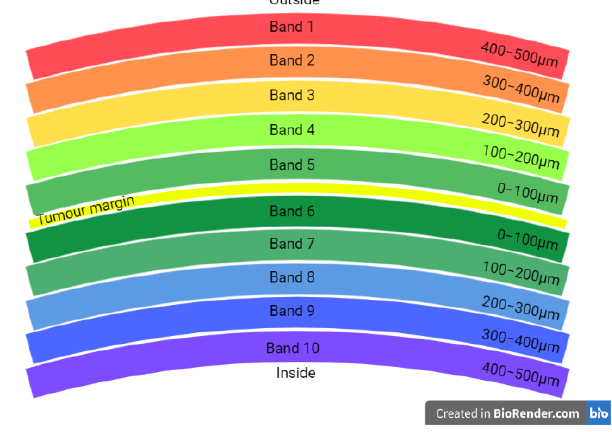
Figure 3. Schematic representation of distance bands assessed in infiltration analysis. The tumour margin is represented by the yellow line between band 5 and 6. Each band was 100 µ m in thickness. Marker densities were quantified in each band separately as well as in multiple adjacent bands (see Figure 1).